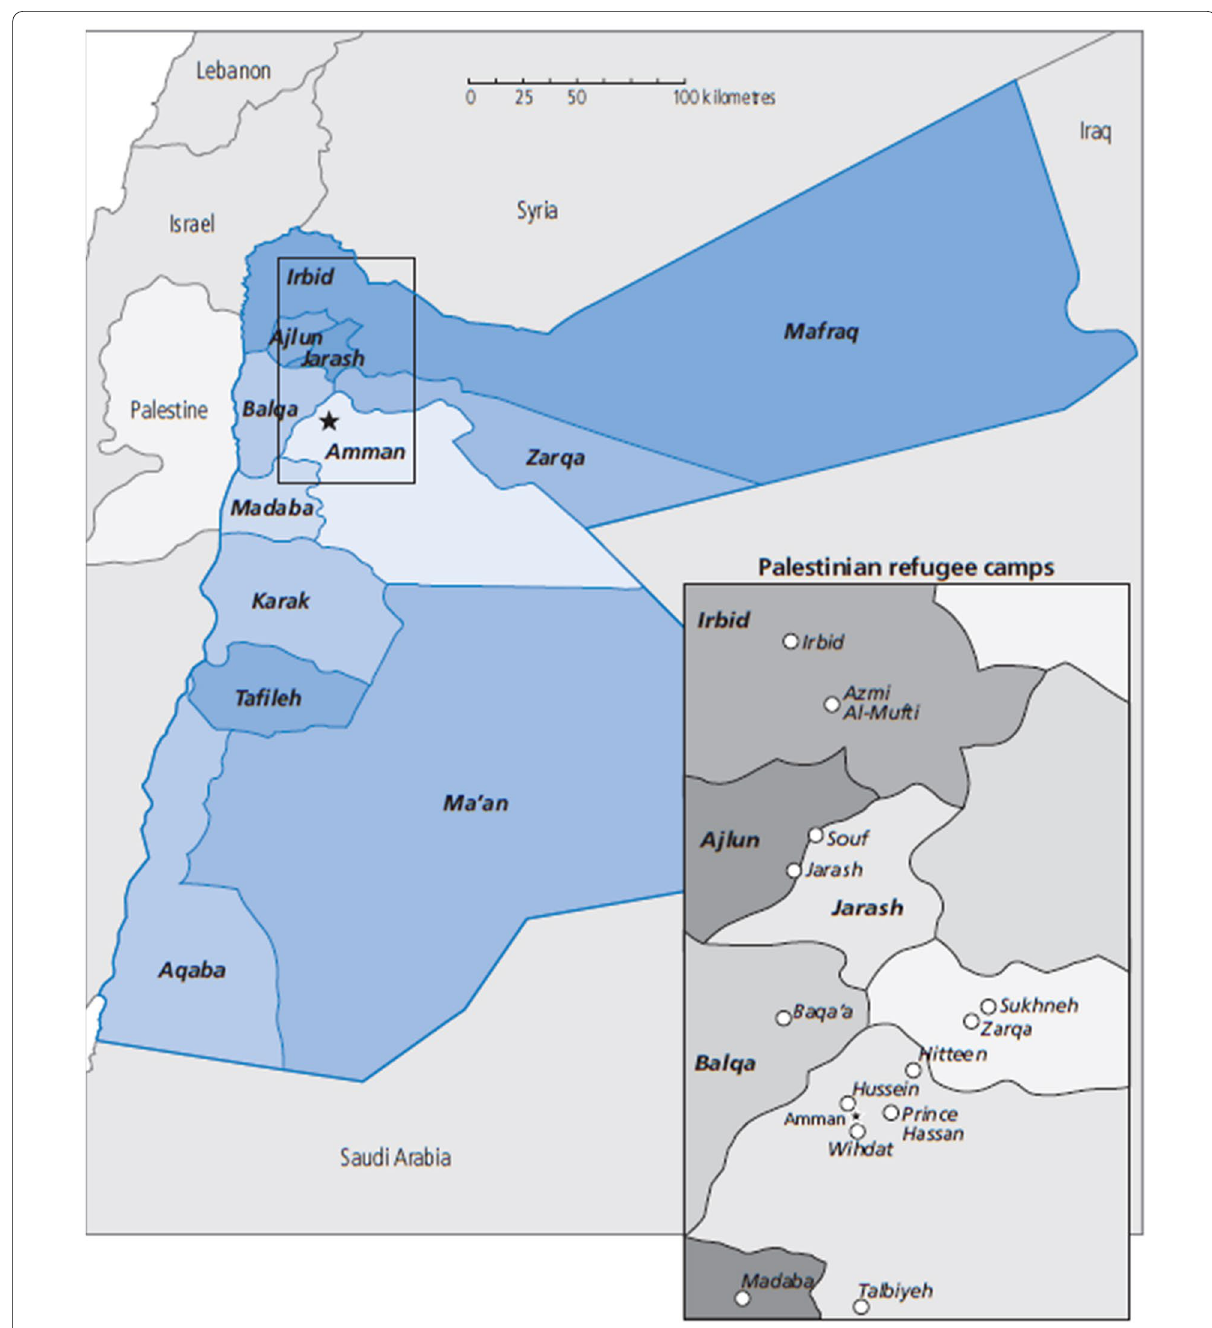
Fig. 1 Map of Jordan with Palestinian refugee camps (UNRWA